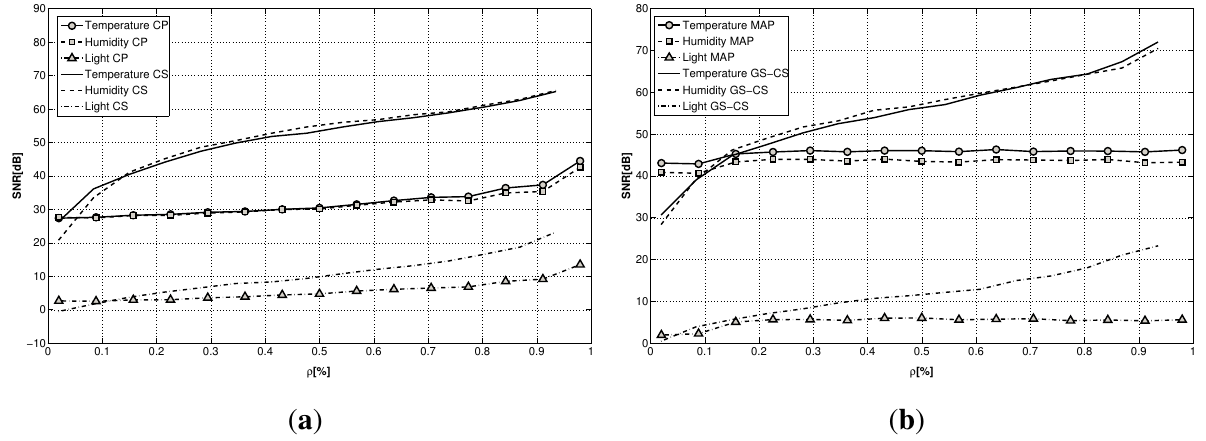
Figure 4. Recovery comparison when reconstructing the original signals from sub-sampled versions ( N = 512 ): ( a ) compressive sensing (CS) and latent variable (LV) tensor factorization averaging the reconstruction quality over all of the nodes; ( b ) GC-CS and maximum a posteriori (MAP), exploiting the correlations among sensors and nodes.